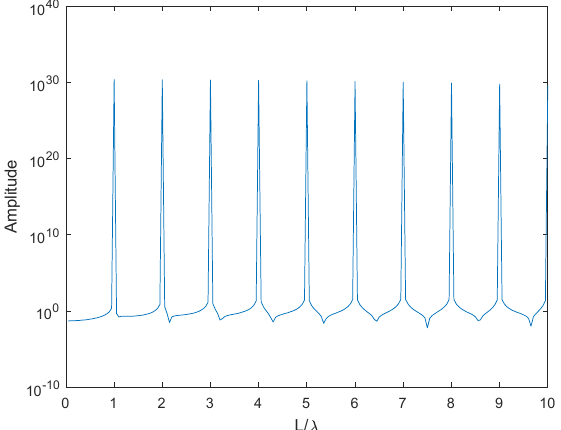
Figure 3. Radiation capability (y − mode dipole).